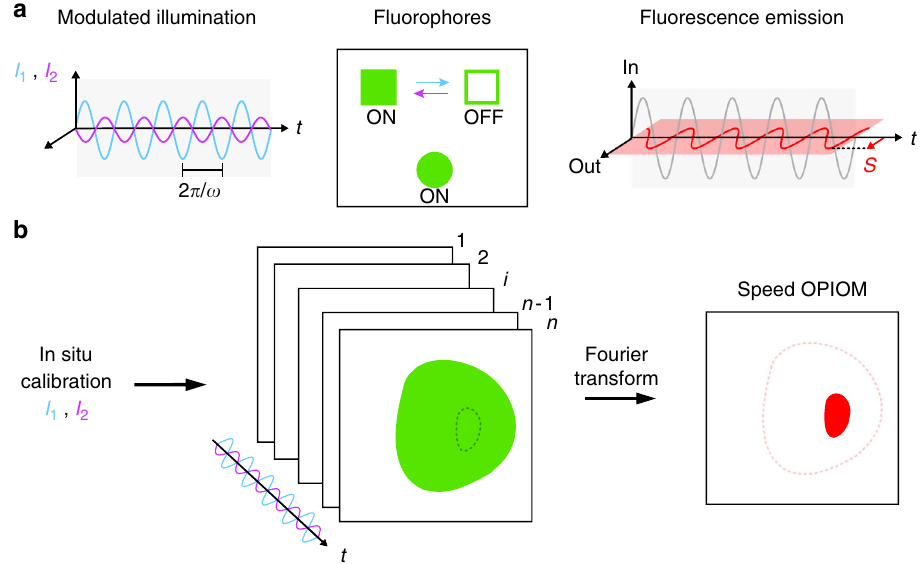
Fig. 1 Principle of speed OPIOM. a A sinusoidally modulated antiphase-synchronized dual illumination generates the quadrature-delayed component S (in red ) of the fl uorescence emission used for selective speed OPIOM imaging of RSFPs. b After in situ calibration, the fl uorescence images are recorded under modulated illumination and processed to yield S after Fourier